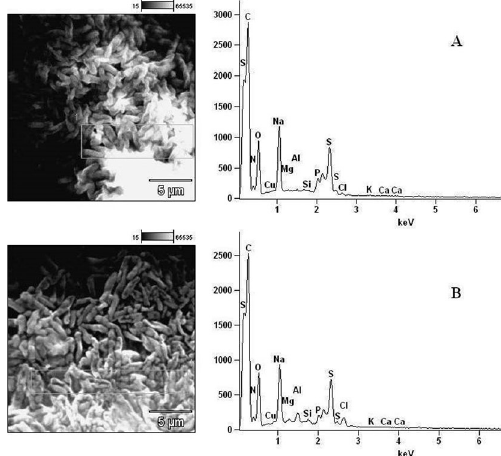
Fig. 9. Elemental components of (A) extract-untreated B. pumilus and (B) extract-treated B. pumilus